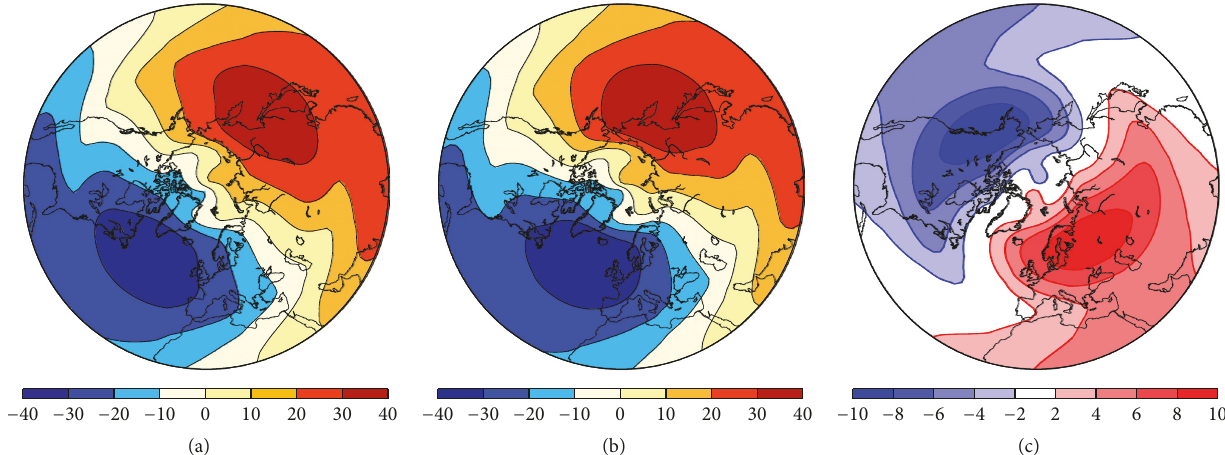
Figure 5: Zonal wavenumber-1 component of mean geopotential height (gpm) of the 833 hPa model level for the low (a) and high (b) Arctic sea-ice-cover conditions and (c) their difference (low minus high)